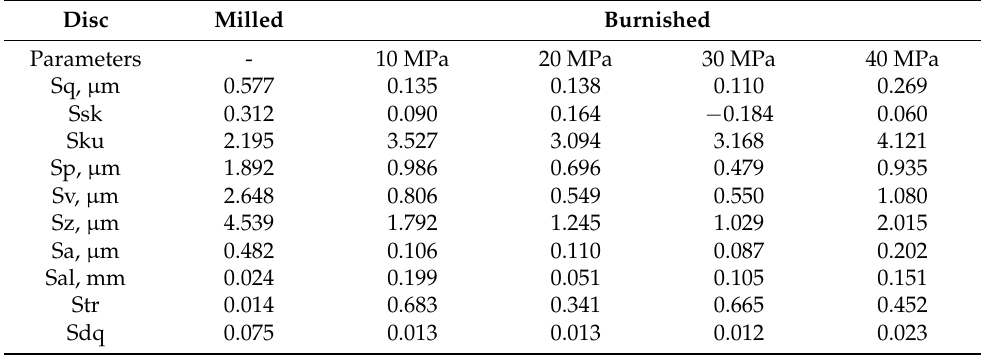
Table 1. Selected areal parameters of disc